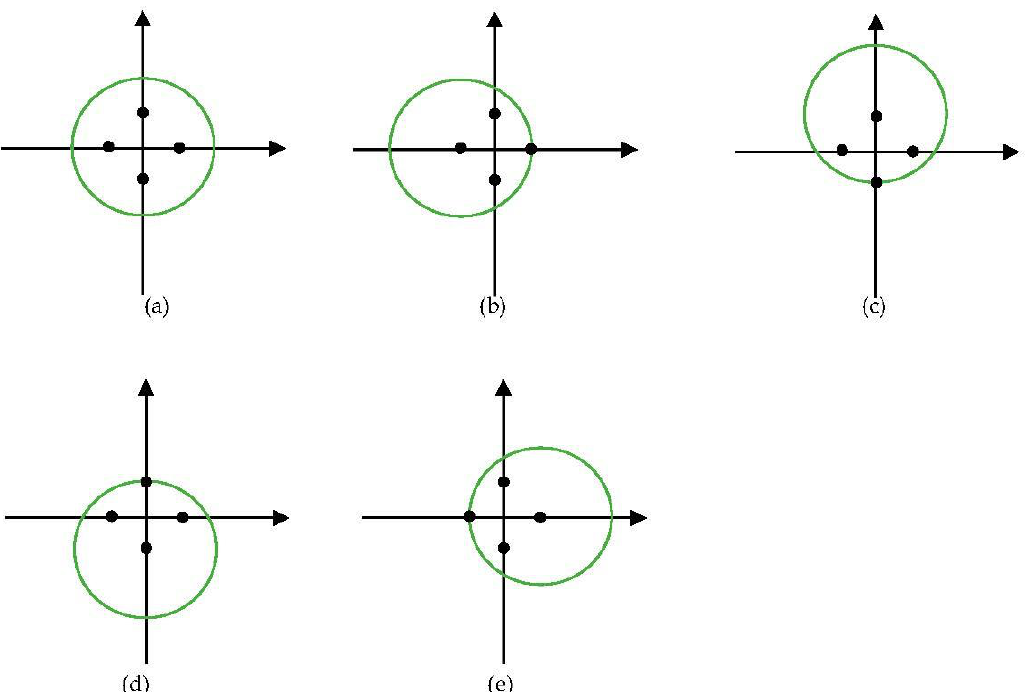
Figure 3. Views of the five positions of a tree. The green circles represent trees viewed from the zenith. Black points are the four normalization positions. ( a ) Normalized by center; ( b ) Normalized by (x + w/2, y); ( c ) Normalized by (x, y − w/2); ( d ) Normalized by (x, y + w/2); ( e ) Normalized by (x − w/2, y).